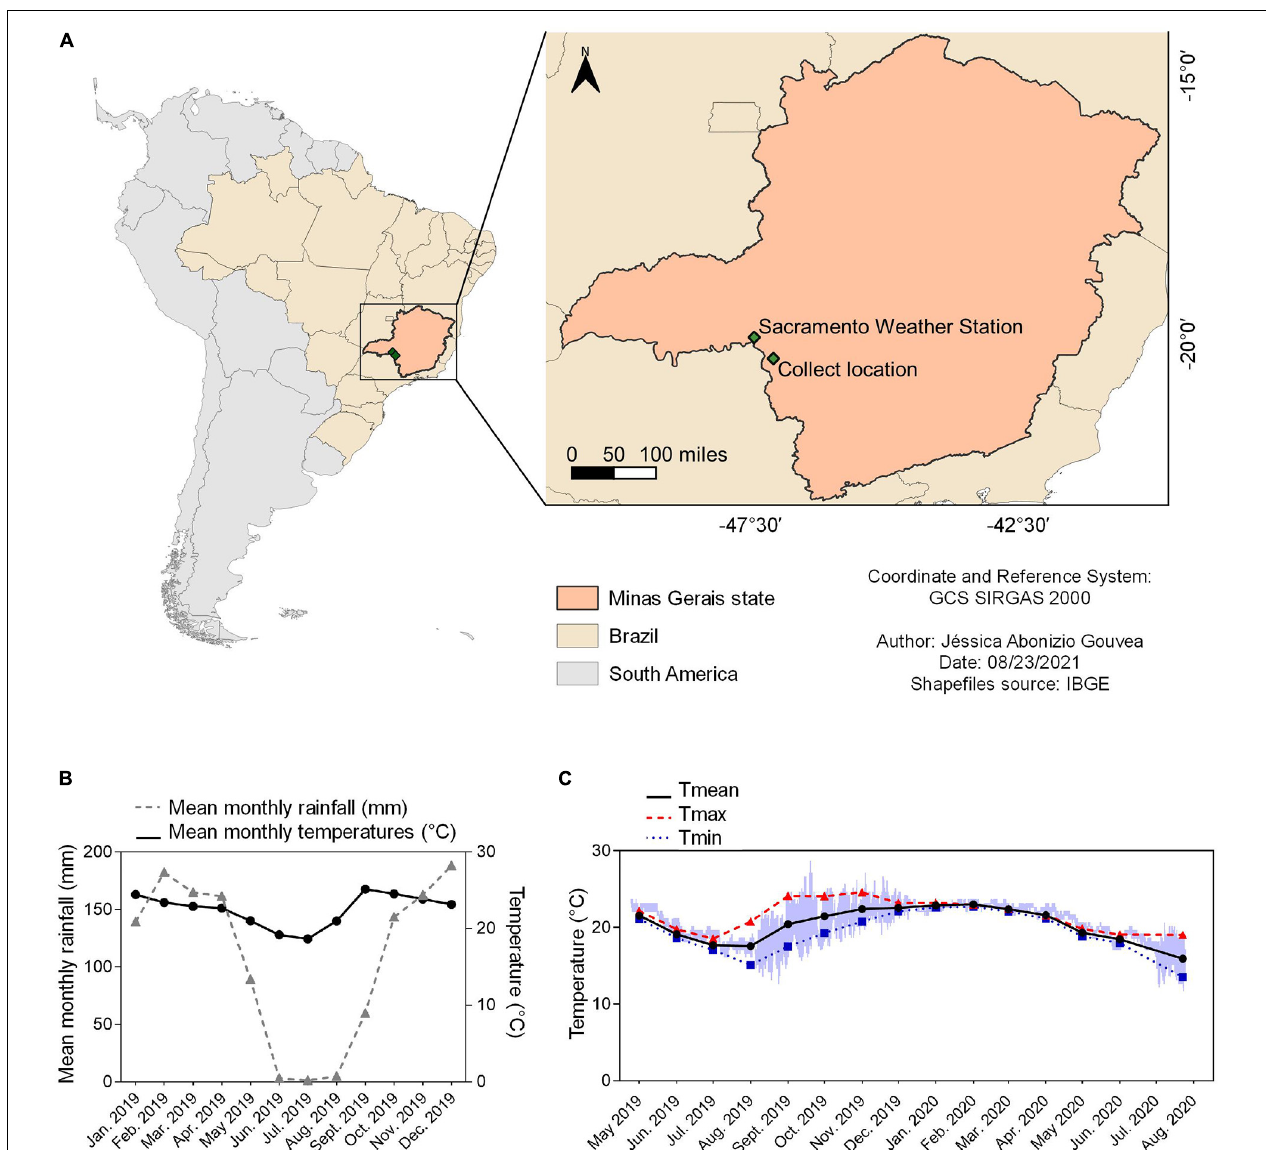
FIGURE 1 | Summary of environmental data for the location that B. ibitiguara inhabits, compared to the weather station. (A) Minas Gerais state highlighted on the map of Brazil, showing the capture site of tadpoles of B. ibitiguara (B) and the nearest weather station (C) , at Sacramento city (at a distant of 87.2 km). (B) Mean monthly temperatures (black line) and rainfall (blue line) for the year 2019 obtained from the Sacramento weather station. (C) Minimum (blue line), maximum (red line) and mean (black line) monthly records of water temperatures in the permanent stream where tadpoles were captured. The data logger collected temperature data every hour from April 24th of 2019 to July 25th of 2020. The time interval estimated for the dried season is from May to September [see graph in panel (B) ], when, at some point (the total duration is impossible to be determined) the stream displayed decreased water levels and thus and thus, the temperature sensor recorded air